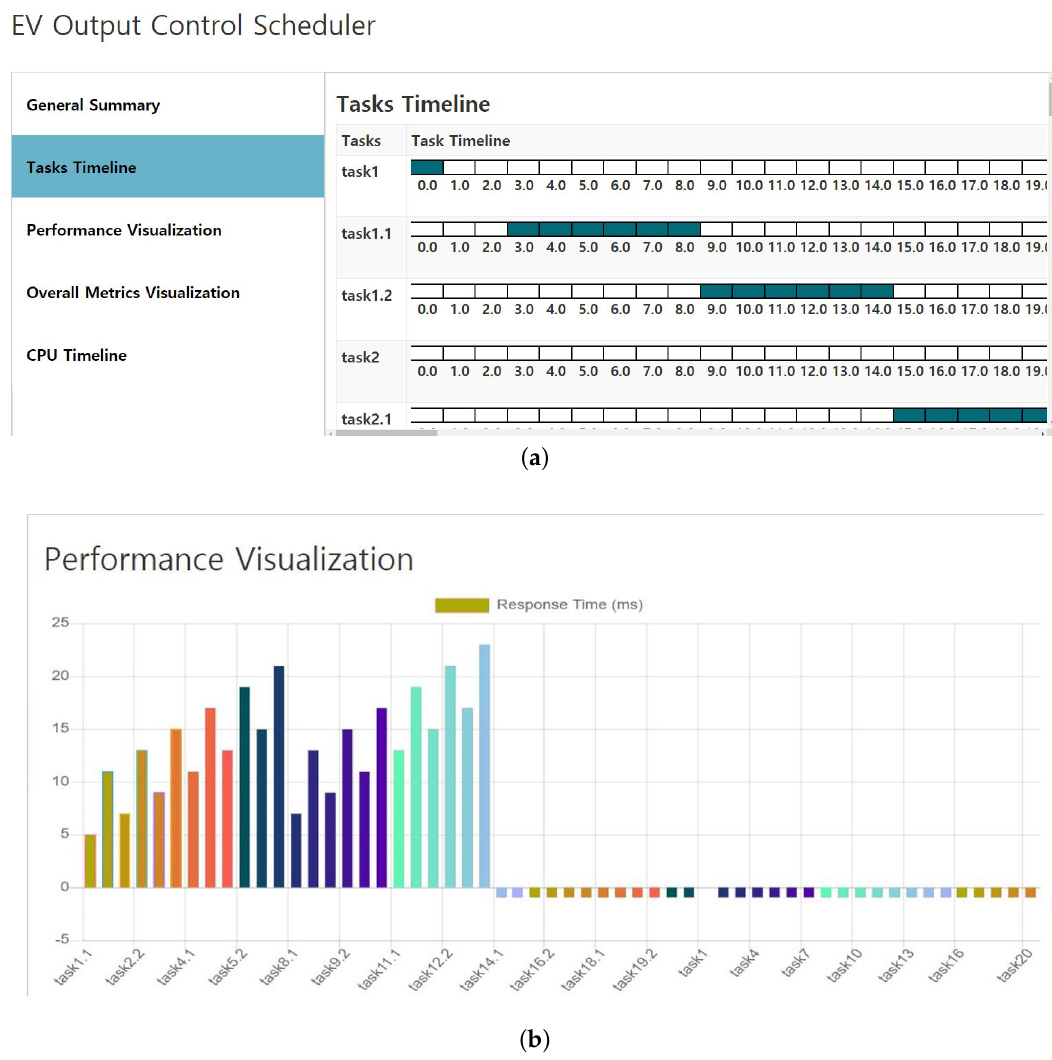
Figure 7. Interface for ( a ) task timeline and ( b ) performance visualization of EV output control